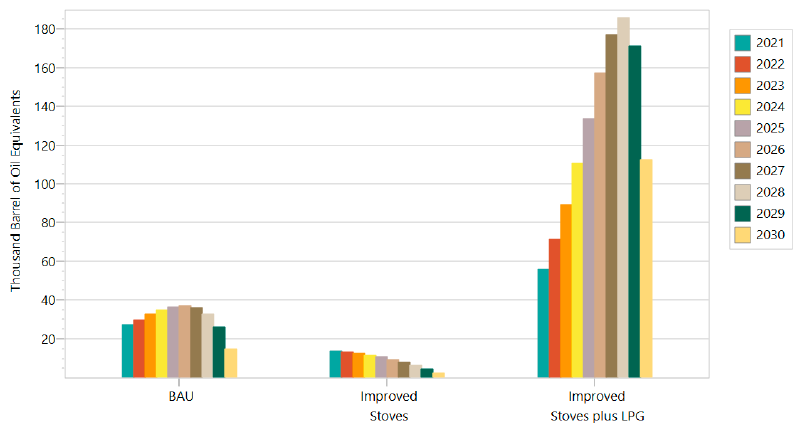
Figure 18. Comparison of the different scenarios in the LPG Consumption for the stoves plus LPG scenario. Period 2021–2030. Urban residential area not electrified.